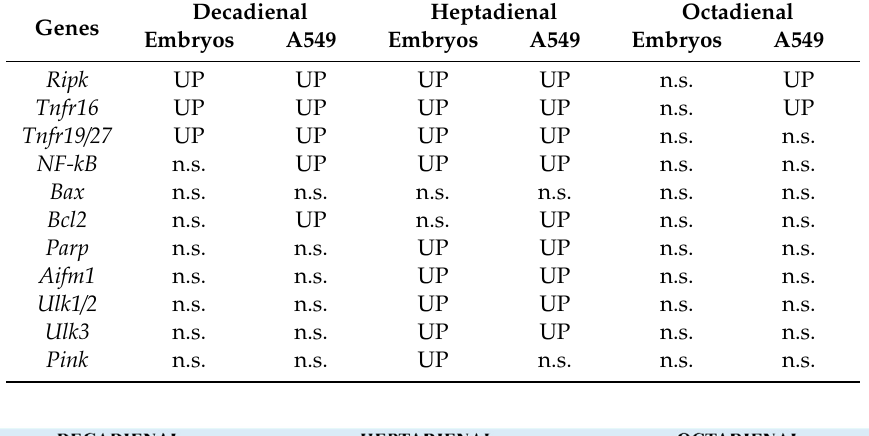
Table 2. Up- and downregulation of genes studied in sea urchin Paracentrotus lividus embryos (at the highest concentration, at 48 hpf) and A549 cells (at 5 µ M, for 2 h). n.s. indicates non-significant gene expression.